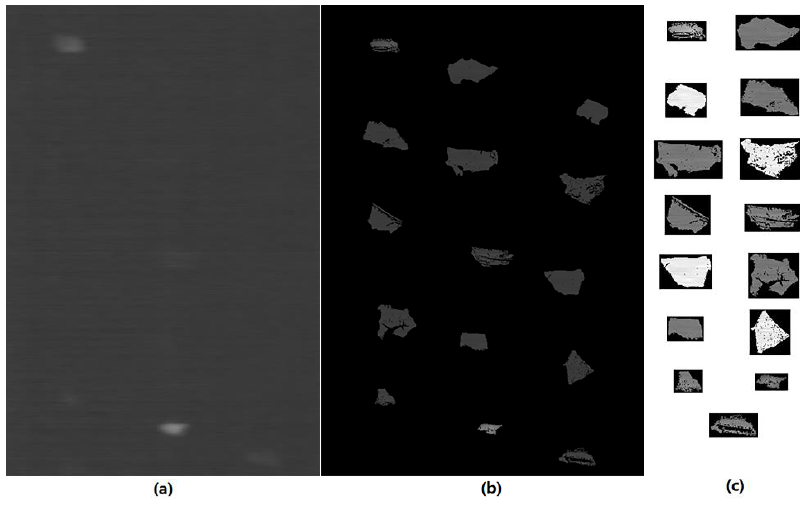
Figure 11. Temperature information acquisition from infrared thermal image: ( a ) original thermal image; ( b ) mask on the thermal image; and ( c ) segmented area of object scraps of thermal image.